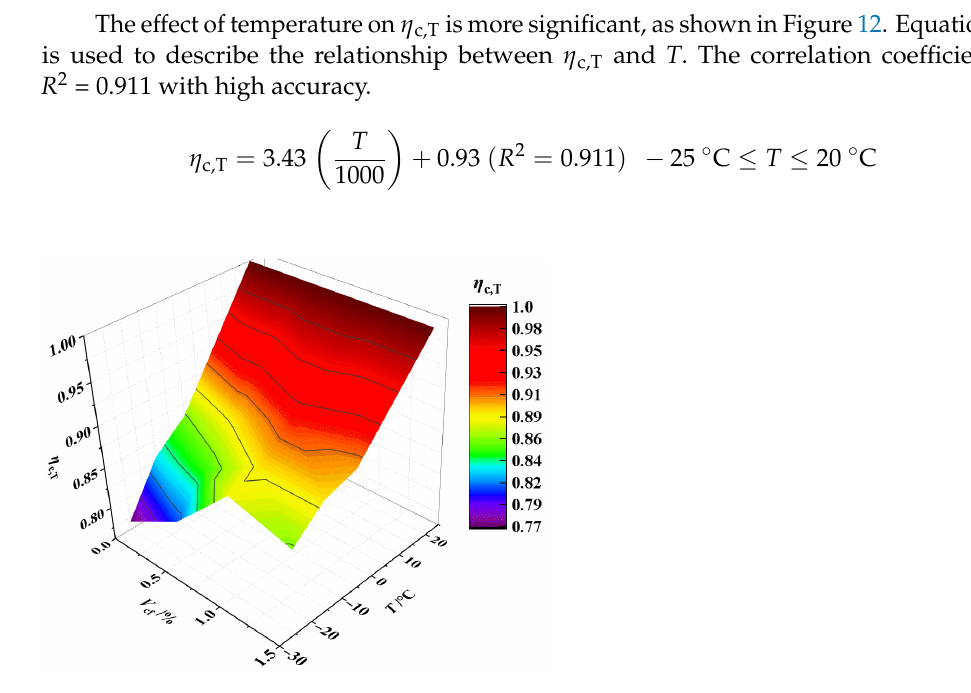
η vs. T and V cf. Figure 12. Relationship η c,T c,T vs. T and V cf